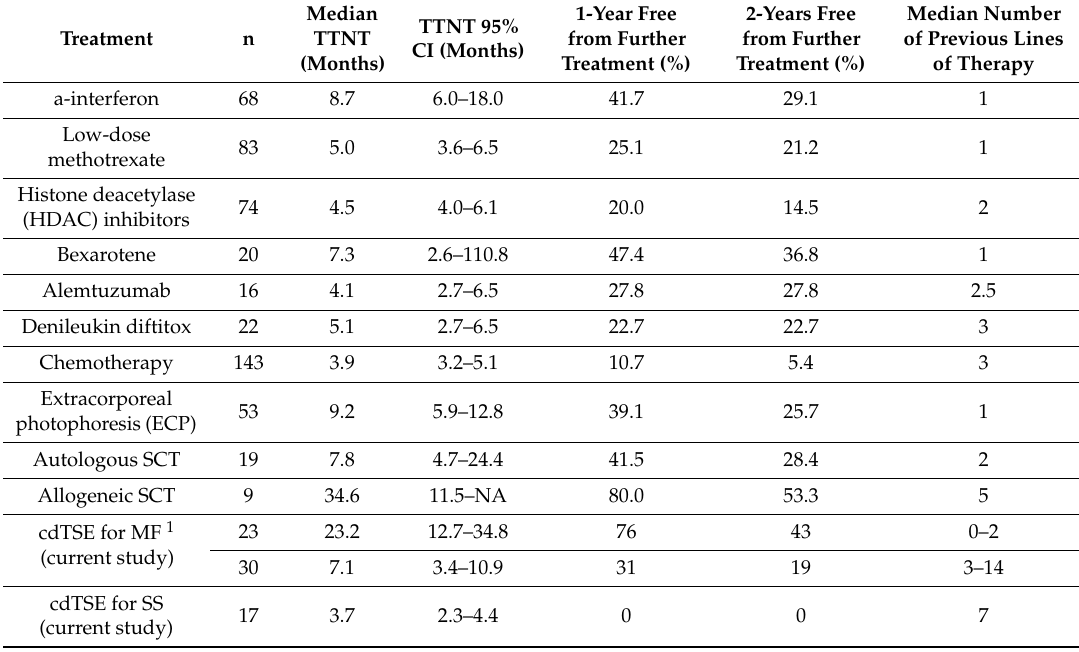
Table 3. Comparison of the time to next treatment (TTNT) following conventional-dose total skin electron therapy (cdTSE) in this cohort and the TTNT of other therapies as reported in a previous publication from our group